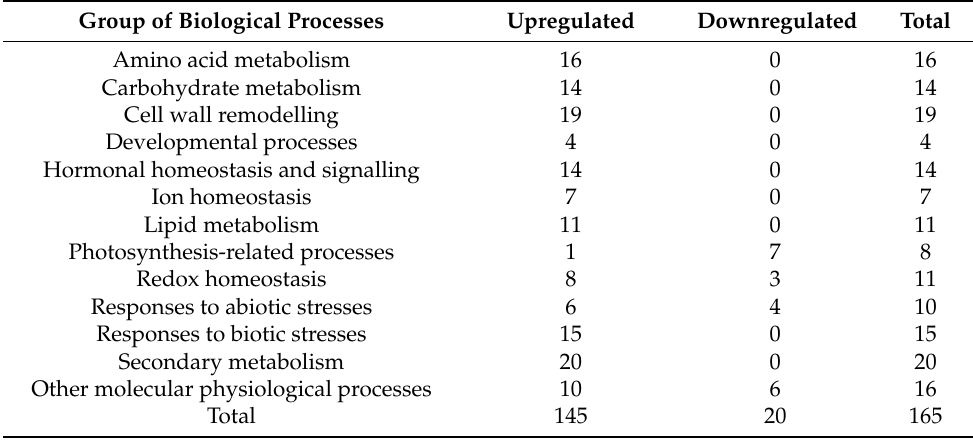
Table 1. Classes of biological processes in Solanum dulcamara that significantly responded to